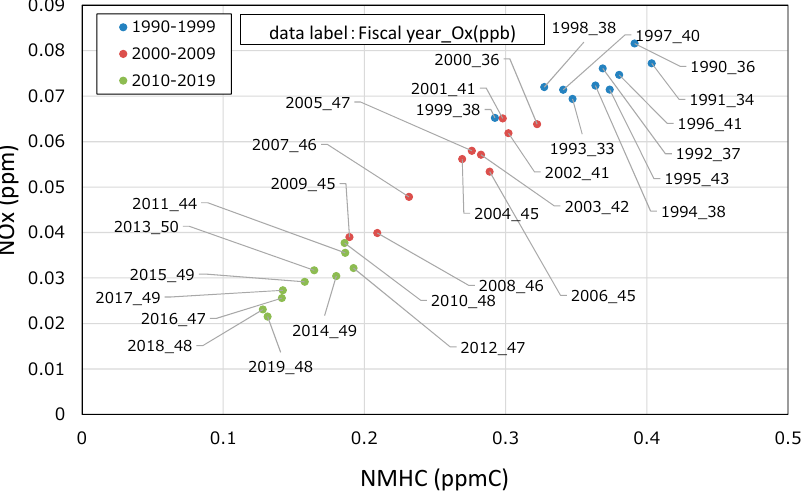
Figure 25. Relationship between Ox, NOx, and NMHC. Ox: annual averages of daily maximum of Ox at all nine General sta. NOx: annual averages of three-hour average of NOx from 6 a.m. to 9 a.m. at all nine General sta. NMHC: same as Figure 23.